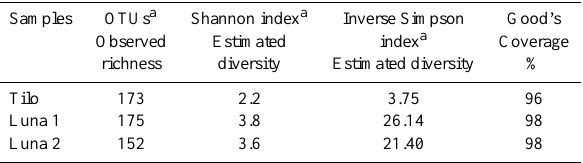
Table 2. Observed richness, diversity indexes and sequence cover- age for the Tilo and Luna rocks based on 16S rRNA gene sequence assignments with a 95% sequence similarity